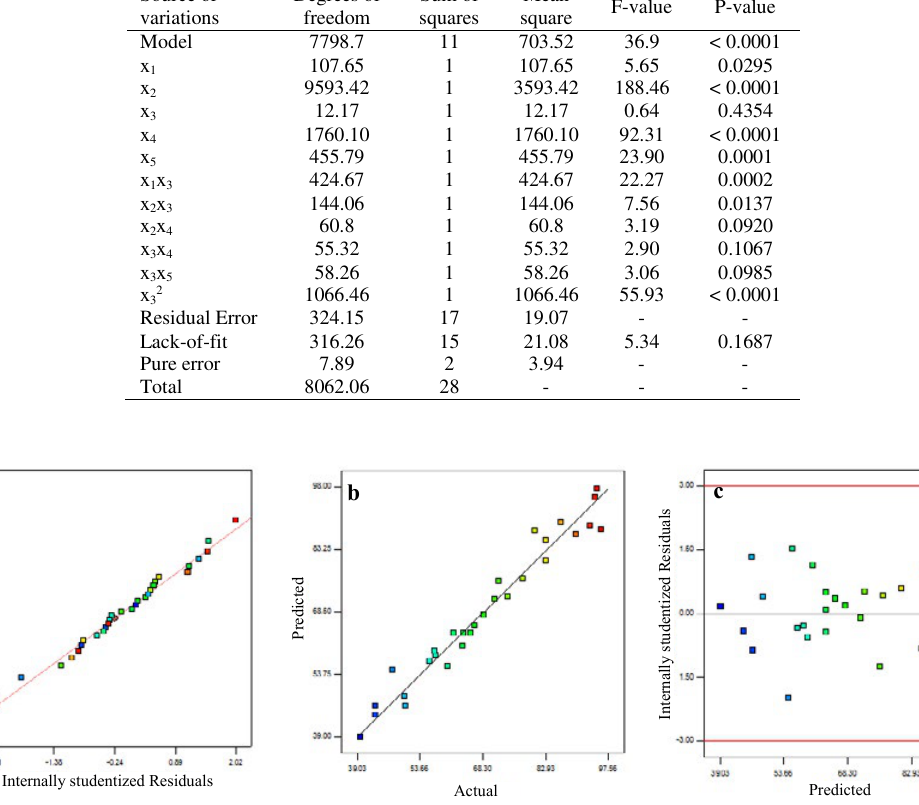
Fig. 13. Residual analysis (a) Normal Plot of Residuals, (b) Predicted Plot vs. Actual, (c) Residuals Plot vs. Predicted.